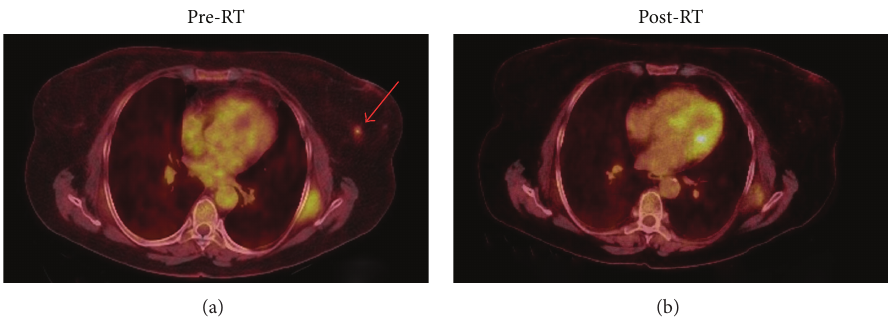
Figure 2: Pretreatment axial PET showing left breast mass with avidity in the left breast (a) and posttreatment axial PET showing complete response with no avidity present in the left breast